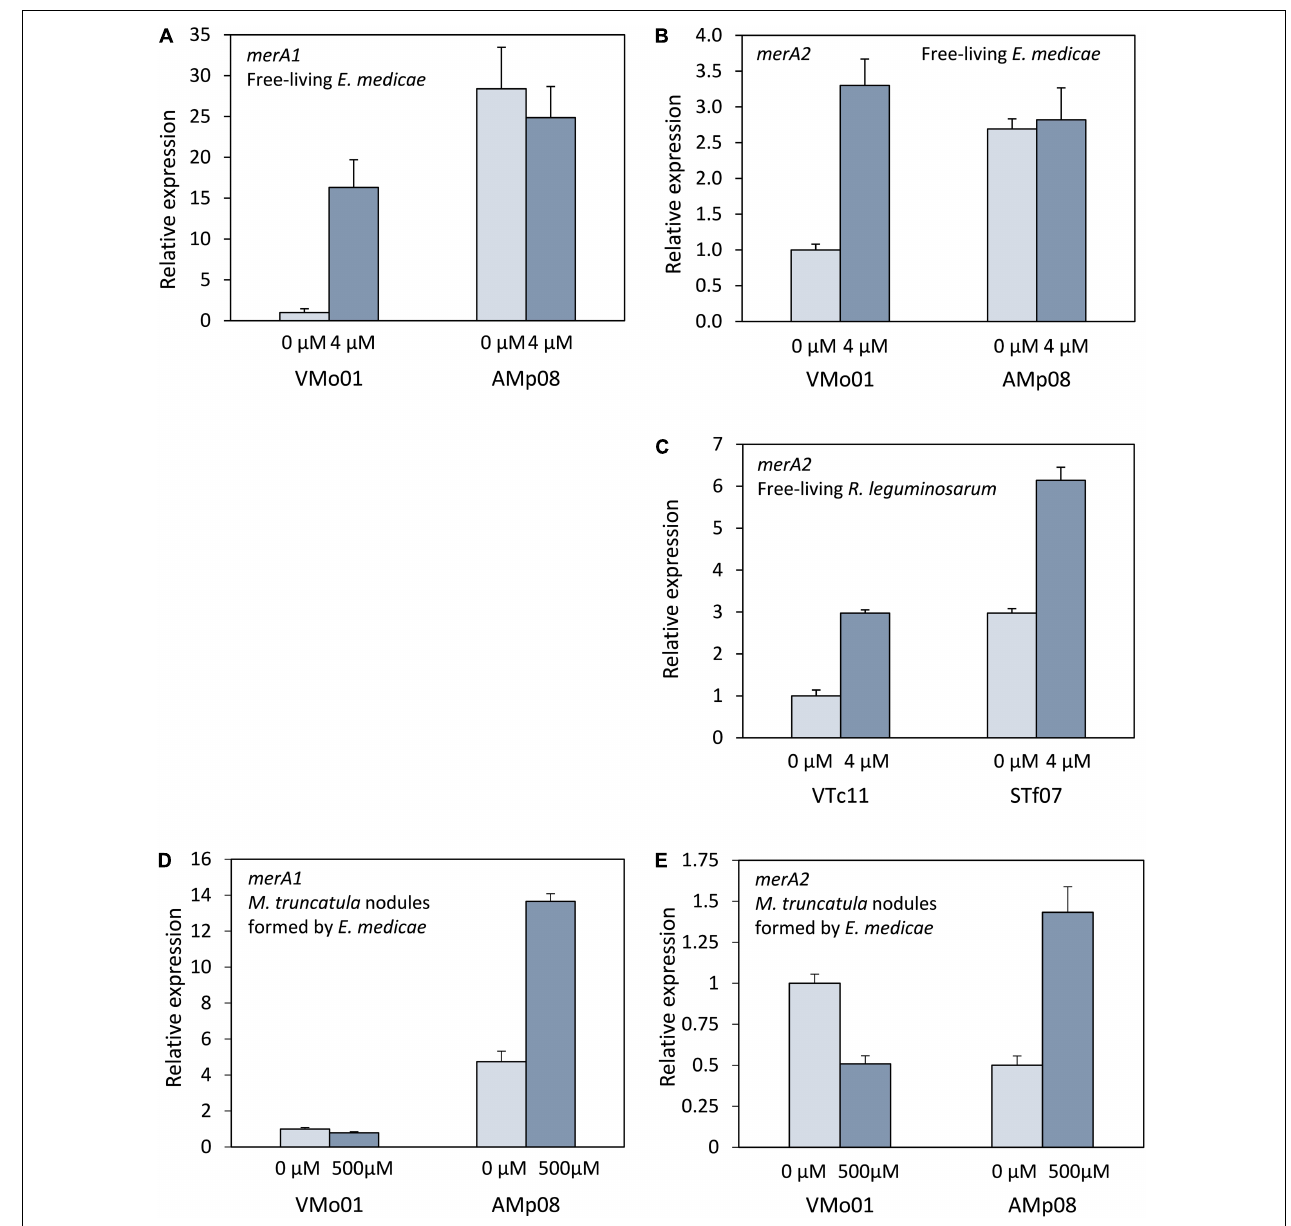
FIGURE 2 | Expression of merA in free-living rhizobia and in Medicago truncatula nodules. (A) merA1 expression in free-living E. medicae strains VMo01 (sensitive) and AMp08 (tolerant). (B) merA2 expression in free-living E. medicae strains VMo01 and AMp08. (C) merA2 expression in free-living R. leguminosarum bv. trifolii strains VTc11 (sensitive) and STf07 (tolerant). (D) merA1 expression in M. truncatula nodules formed by E. medicae strains VMo01 or AMp08. (E) merA2 expression in M. truncatula nodules formed by E. medicae strains VMo01 or AMp08. Free-living bacteria were grown in the absence (0 µ M) or presence of 4 µ M HgCl 2 . Three independent biological experiments were performed. Five week-old nodulated M. truncatula plants were watered with nutrient solution containing 0 or 500 µ M HgCl 2 and harvested after 24 h. Three independent biological experiments were performed. Each biological sample contained nodules pooled from 4–6 plants. Three technical replicates per sample were performed. Mean values ± SD are represented. Differences were considered significant when fold change was ≥ 2 and SD bars did not